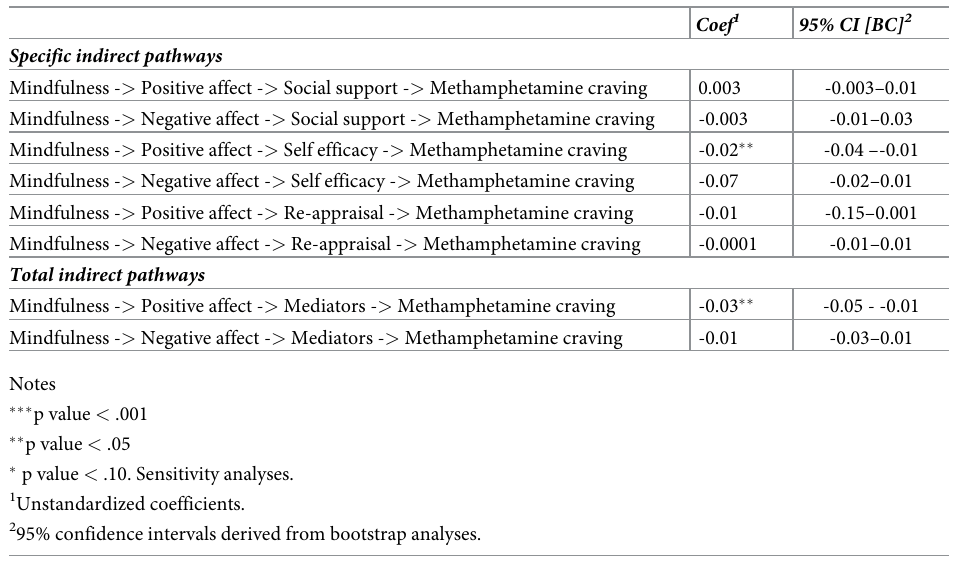
Table 2. Indirect pathways of mindfulness on methamphetamine craving (N = 161).